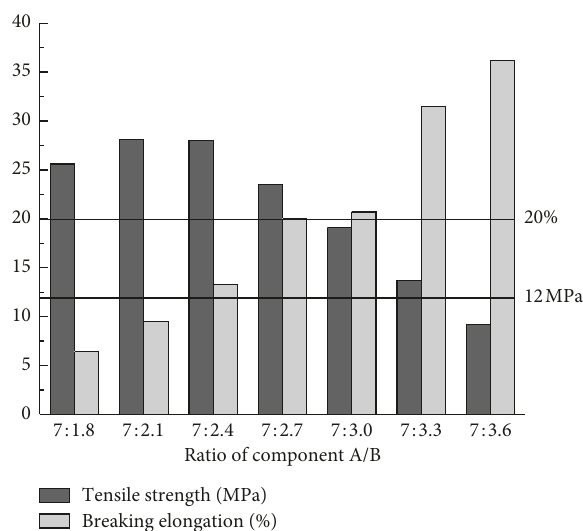
Figure 4: Proportioning effect of Component A: B ratio on ma- terial’s tensile properties after 28day’s